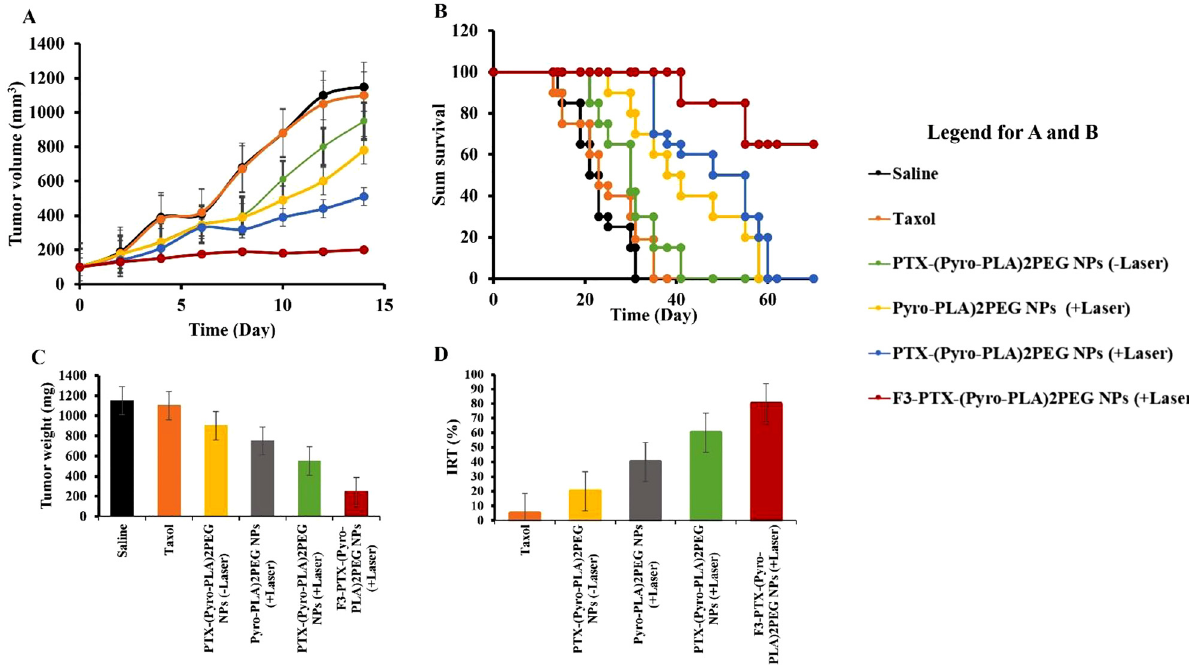
Figure 28: Antitumor effect with 2.5 mg/kg of Pyro, (Pyro-PLA) 2 PEG NPs, PTX-(Pyro-PLA)2PEG NPs and F3-PTX-(Pyro-PLA) 2 PEG NPs, respec- tively, with or without irradiation for 9.8 min with a 660 nm laser, 170 mW cm − 2 . The mice given with saline wereapplied as the negative control. (A) Changes in tumor volume of mice during the 14 days experimental period. (B) Kaplan – Meir survival curve of mice. (C) Weight of dissected tumors. (D) Tumor-growth inhibition (IRT) rate of the various treatment